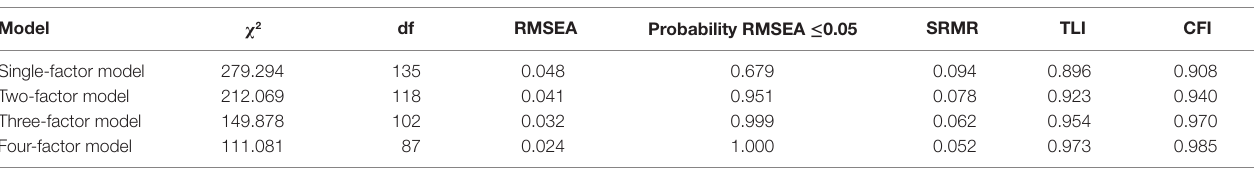
TaBle 3 | comparisons of model fit for need for care. Model χ 2 df